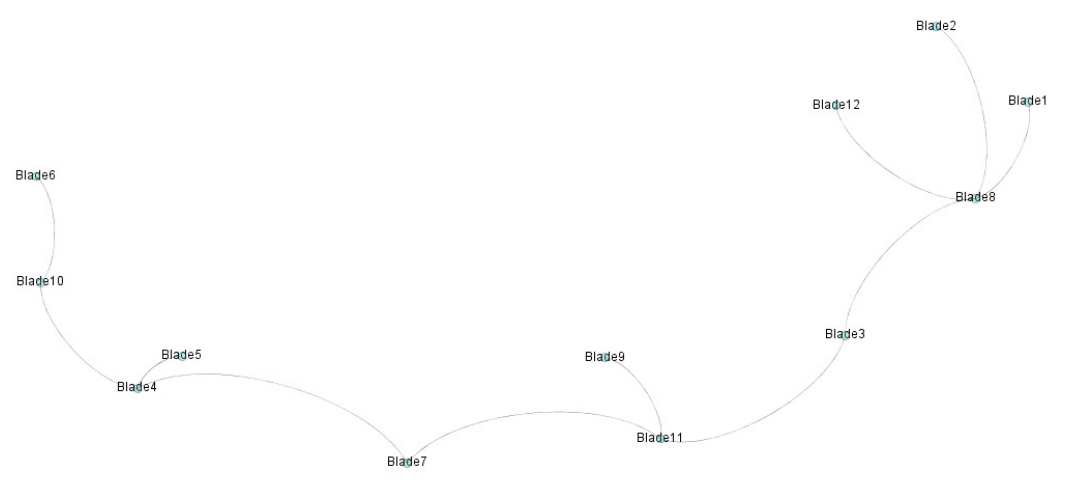
Figure 8. Network graph using the MST of blade clusters using the Force Atlas layout.